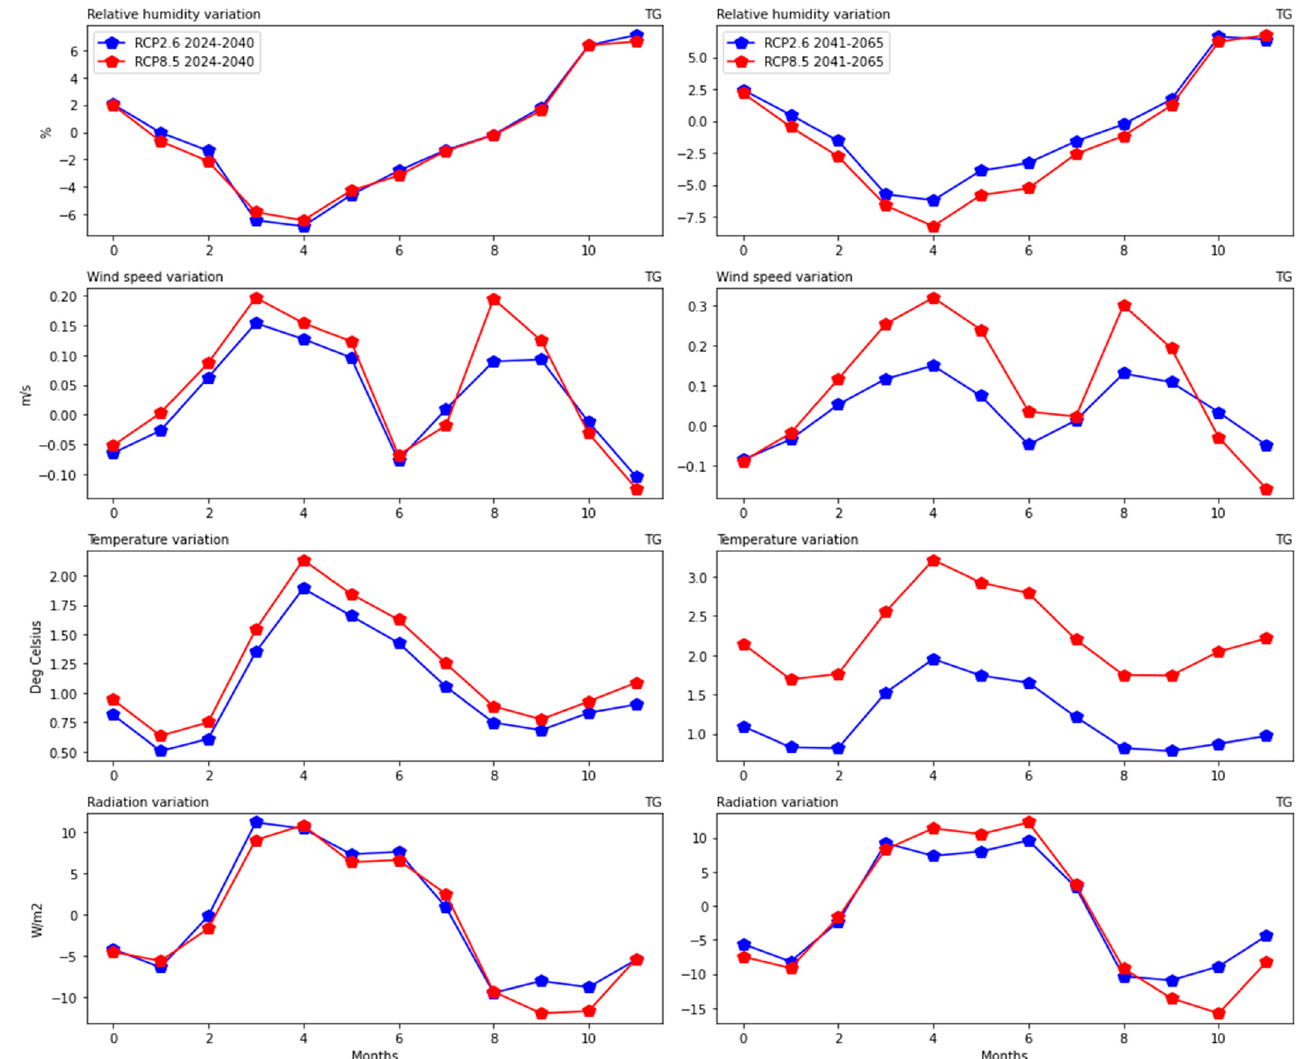
Figure 5. Climatological variation of Rh, Wspd, Tas and Rs over Togo under RCP2.6 and 8.5 scenarios during 2024–2040 and 2041–2065.